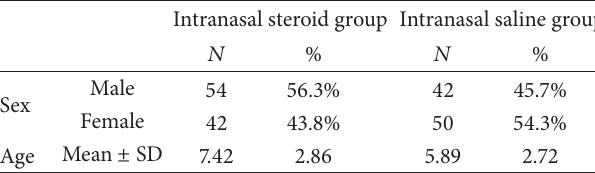
Table 1: Demographic data of the 2 groups of the